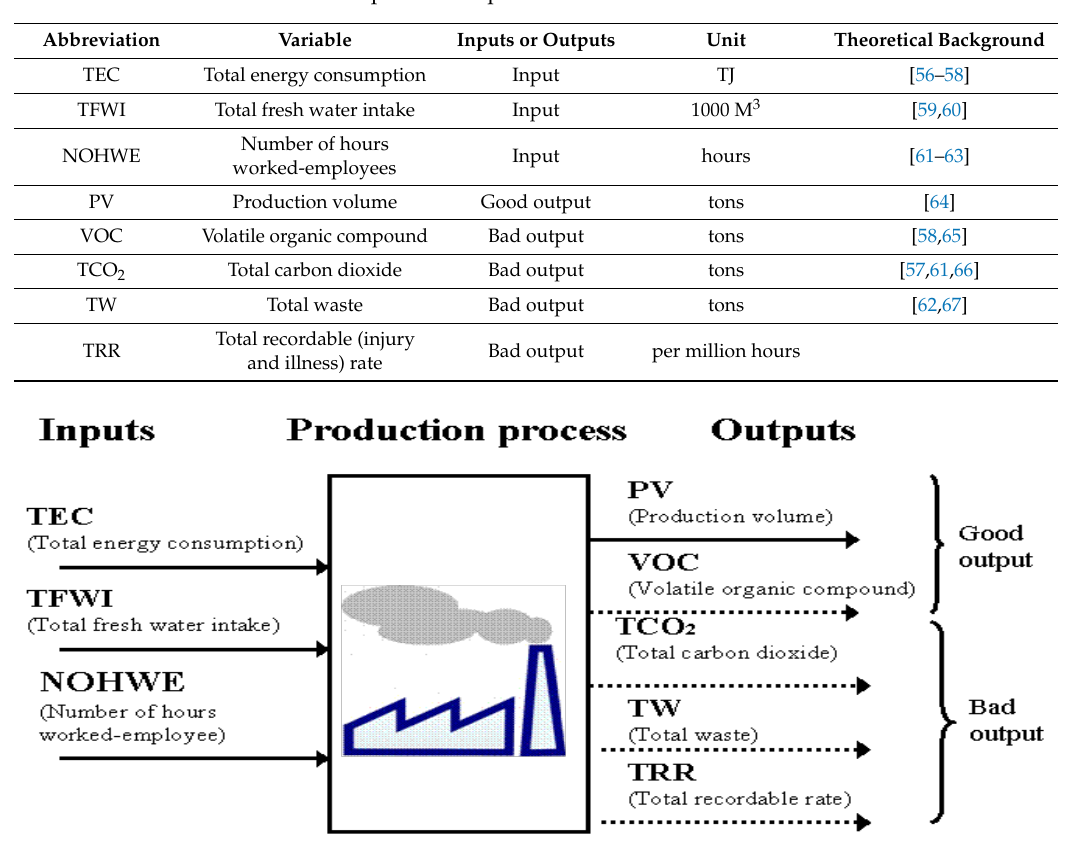
Figure 1. Concept of the DEA model for sustainability analysis.